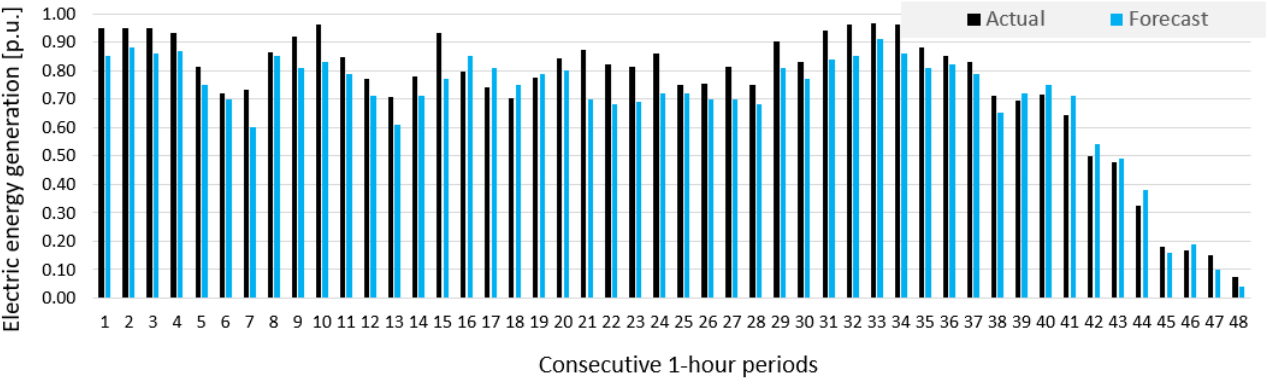
Figure 20. Two forecasts of electric energy generation for Wind Farm A made by INT_OUT_EXT [GBT, RF, PHYS(v1&v2) → KNNR, MLP, LSTM] method with additional expert correction for two consecutive days of the summer month (August). Figures 21–24 provides two forecasts of electric energy generation for Wind Farm B made by the best method with additional expert correction for two following days of each season (from autumn to summer).